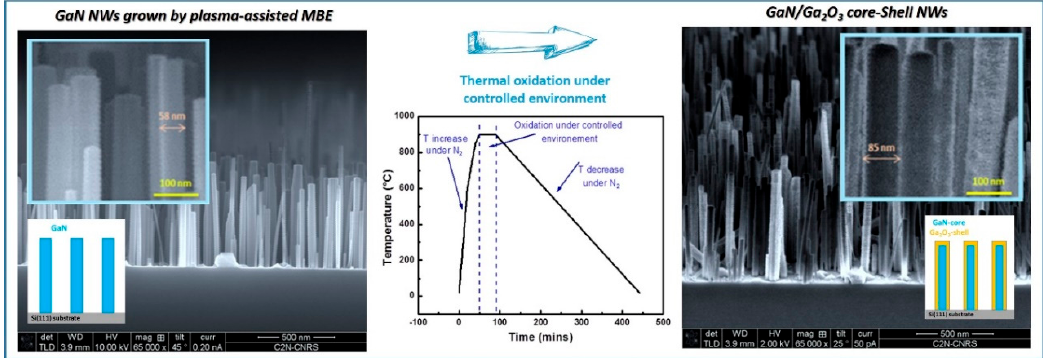
Figure 1. Schematization and SEM images of GaN nanowires (NWs) before oxidation and GaN/Ga 2 O 3 core-shell NWs after oxidation. The cycle of thermal oxidation is also schematized.